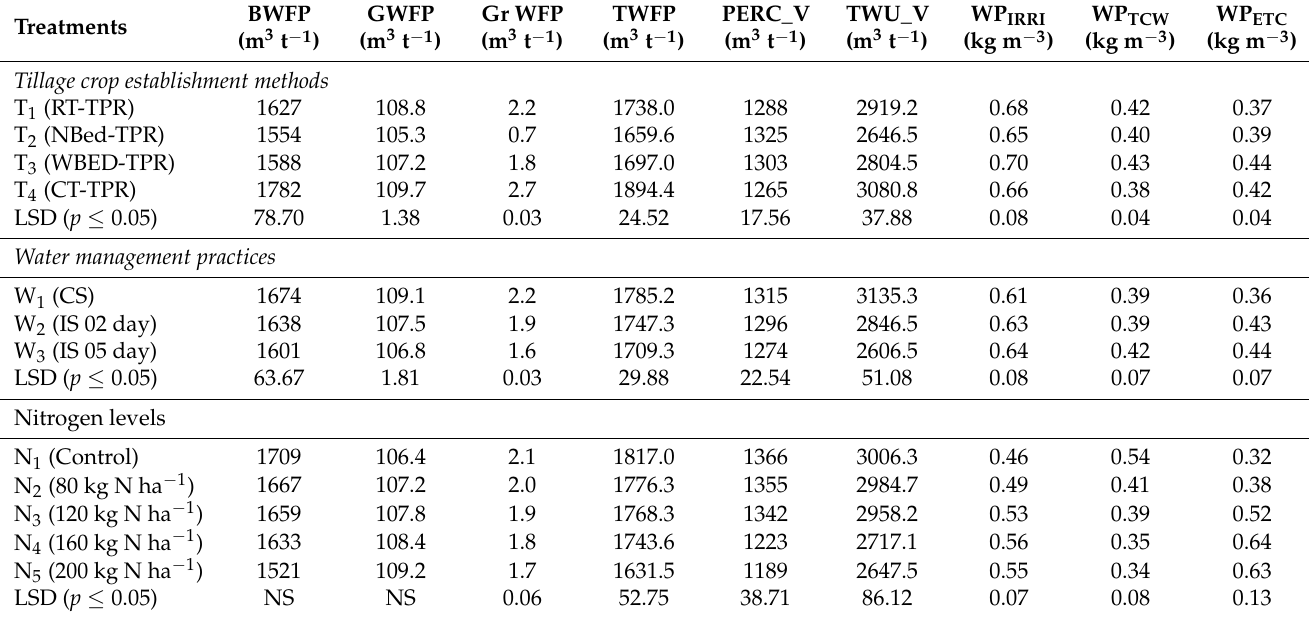
Table 1. The impact of various treatments on footprints and productivity of applied irrigation water in the 2016